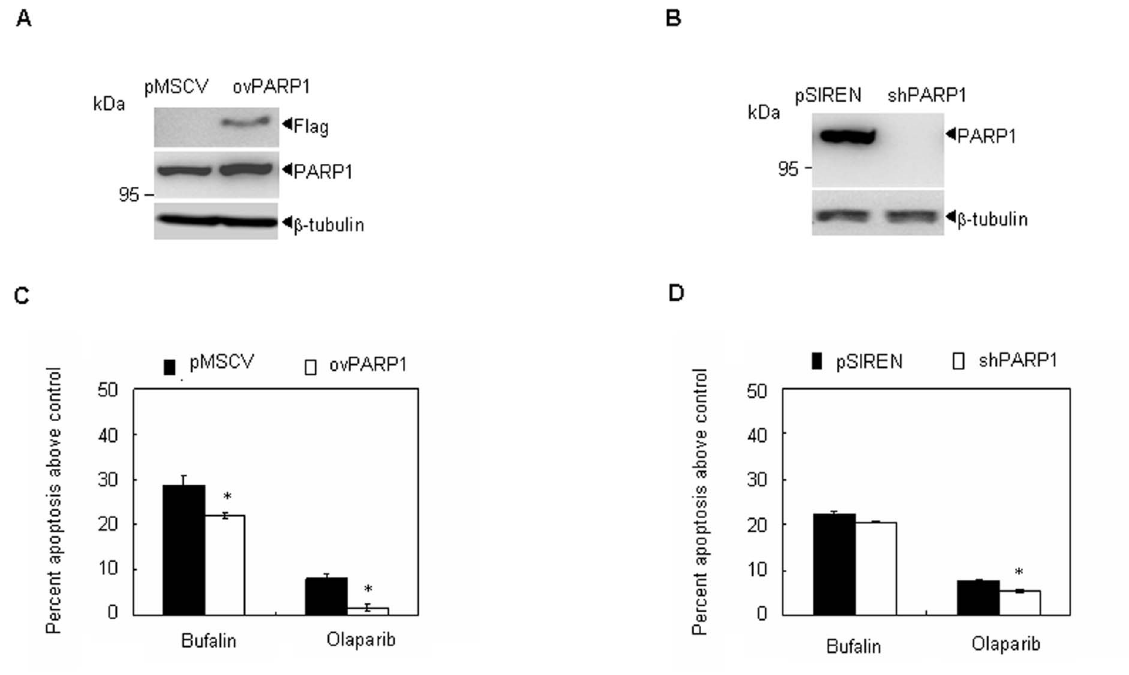
Figure 5. The role of PARP1 in bufalin-mediated apoptosis in MM cells. (A–B) H929 cells were stablely transfected with the control empty vector (pMSCV) or a PARP ovexpression plasmid (ovPARP1), or with the control nonspecific shRNA (pSIREN) or the shRNA against PARP1 (shPARP1), PARP1 expression was measured by western blot. (C) Indicated cells were treated with 20 nM bufalin or 20 m M olaparib for 48 hours. Annexin-V- positive cells were counted using flow cytometry. All values represent means 6 S.D. of three independent experiments, each performed in triplicate ( * P , 0.05, ** P , 0.01, compared to vector transfected controls).